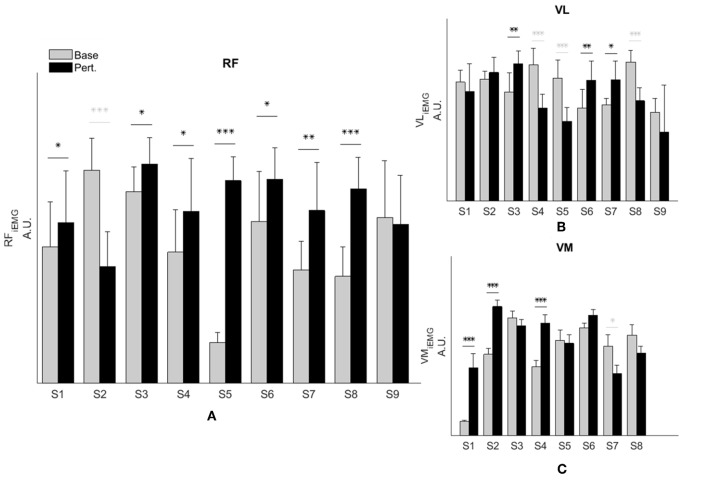
RF activity increases during knee flexion perturbation consistently in people with SKG. RF iEMG (A) and VM iEMG (B) values were increased significantly within the SKG group between baseline and perturbation (p < 0.001, p < 0.005 respectively). No significant changes were observed in VL iEMG (C) values (p = 0.06) based on the repeated measures ANOVA. The increase was more consistent for RF iEMG values across subjects compare to VM iEMG values. “Base” refers to unperturbed Baseline steps, whereas “Pert.” refers to steps with torque perturbations during pre-swing. Significant increase (black) and decrease (light gray) within subjects between baseline to perturbation conditions was determined using Tukey-Kramer post-hoc testing (*p < 0.05, **p < 0.01, ***p < 0.001).